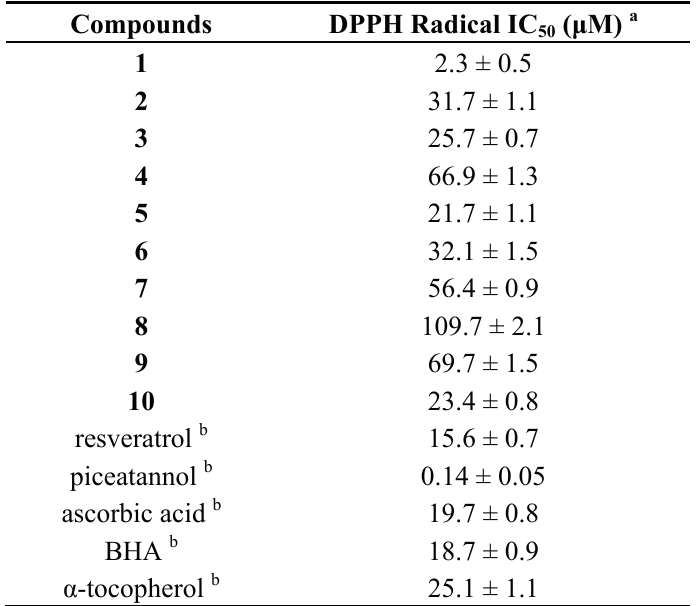
Table 2. Radical scavenging activities of the compounds 1 – 10